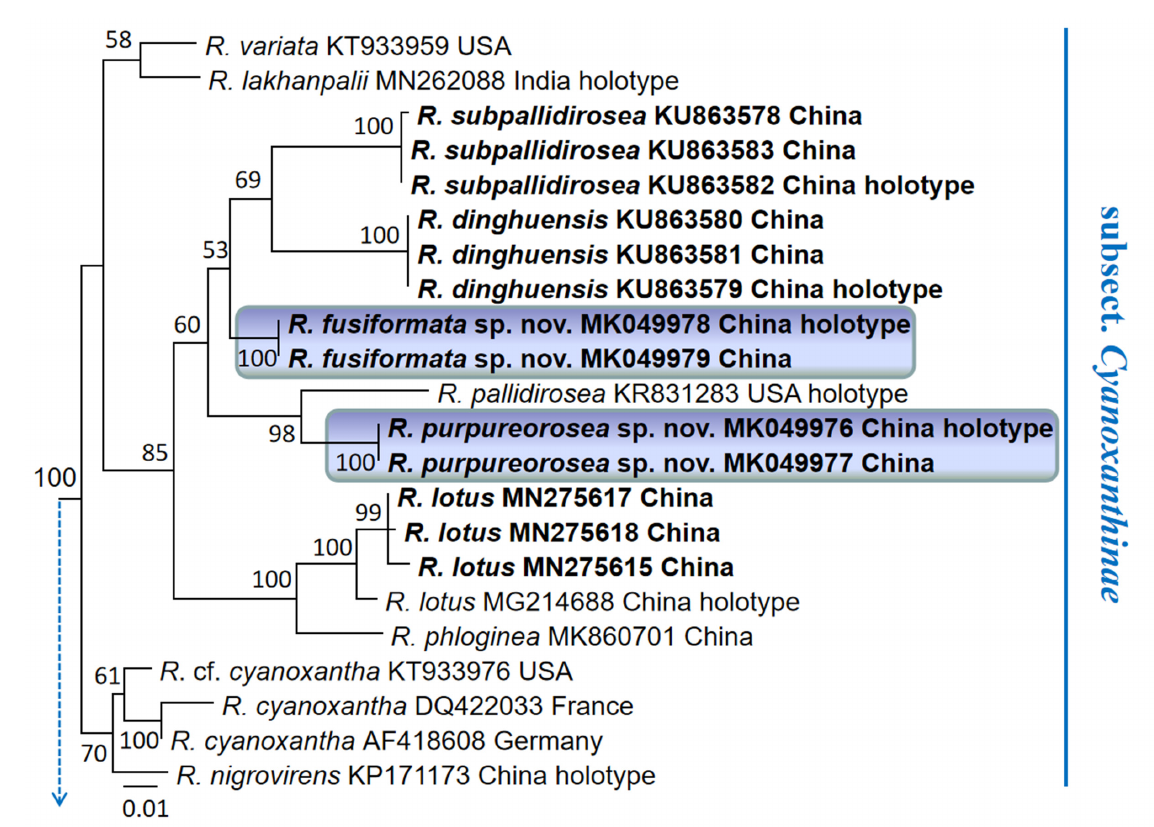
Fig. 1-2. Phylogram of subsect. Cyanoxanthinae Singer. Bootstrap values higher than 50% are shown above or below the branches. Species collected from Dinghushan Biosphere Reserve are shown in bold, the two novel species are highlighted with a blue